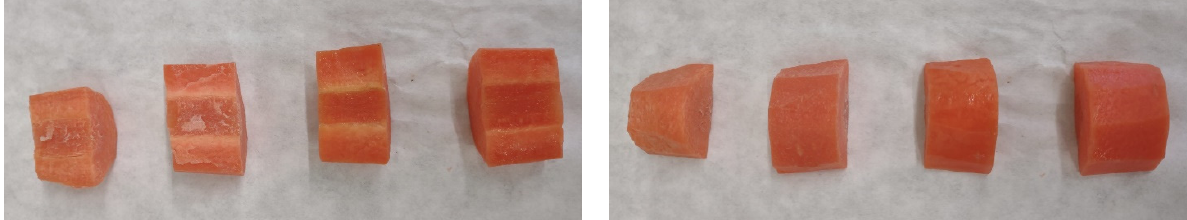
Figure 2. Representative photograph of white blush in vascular cylinder (on the left) and cortical tissue (on the right) of uncoated and coated fresh-cut carrots on the 14th day of storage at 4 °C. From left to right: W; W + LE; PC; PC + LE (abbreviations, see Table 1).